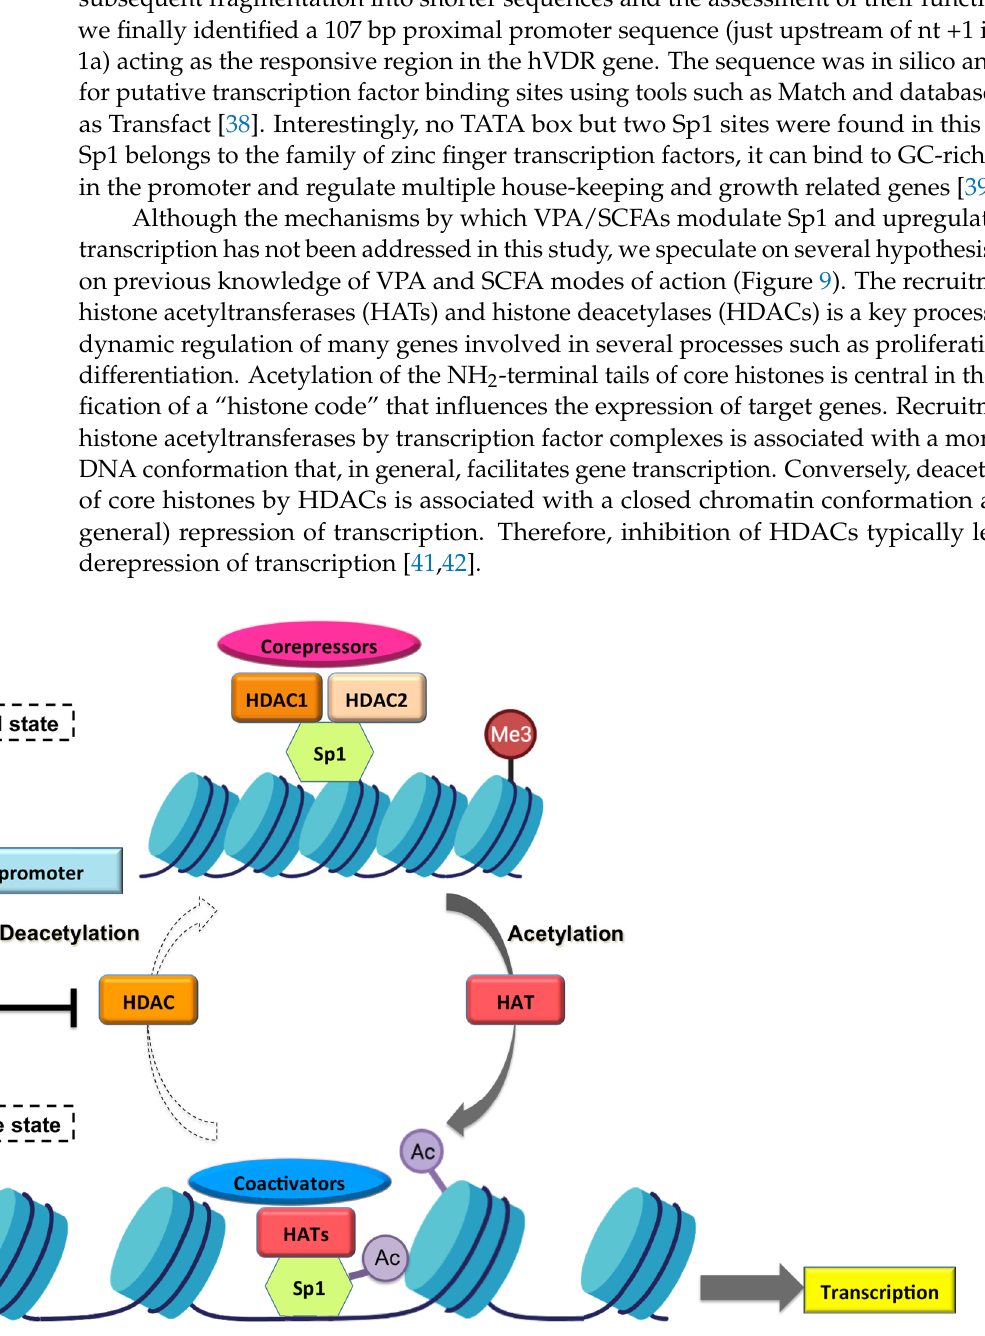
Figure 9. Schematic hypothetical model of VPA (valproic acid)-mediated induction of VDR (Vitamin D Receptor) gene transcription and expression via inhibition of HDACs (histone deacetylases) and chromatin remodeling. The schematic model shows that under untreated conditions class I HDACs (HDAC-1 and -2) interact with Sp1 and form a correpressor complex mantaining histones hypoacetylated.Under these conditions, chromatin is in its non-permissive or repressed state and Sp1 transcription factor has low affinity for the promoter. After treatment with VPA, its HDACi activity inhibits HDACs, which do not compete with HATs. Upon acetylation of histones (and Sp1), chromatin opens and Sp1 occupies the VDR promoter leading to VDR gene transcription. Figure adapted from [43].